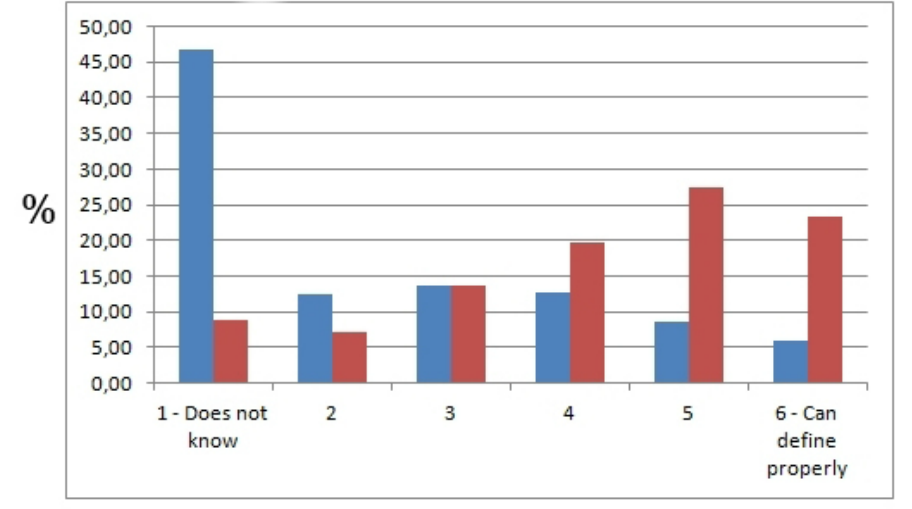
Figure 3. The number of students that could properly define social media. The y axis represents the percentage of students that chose the particular answer. Blue and red bars represent responses acquired before and after the course, respectively.